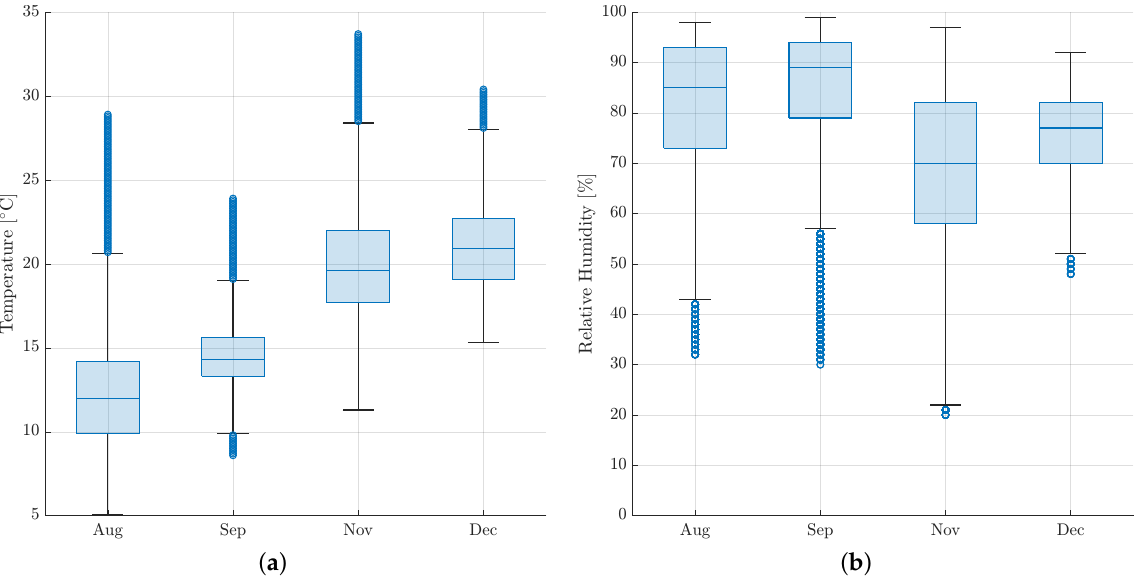
Figure 7. Results obtained from the weather station on the roof of the school. ( a ) shows monthly temperature boxplots. ( b ) shows monthly relative humidity